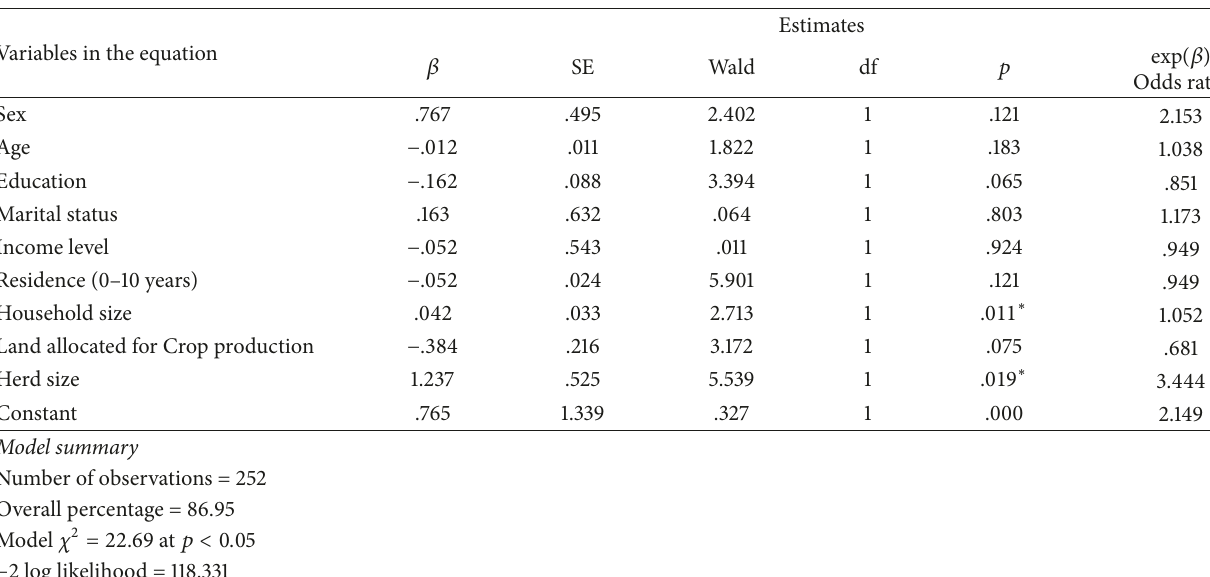
Table 4: Results of logistic regression showing the predictive effect of demographic factors on conflicts over natural resource access. Variables in the